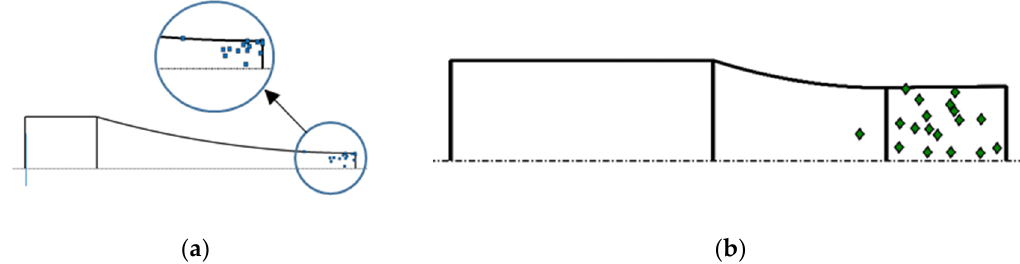
Figure 5. Critical defect distribution: ( a ) hourglass specimens; ( b ) Gaussian specimens.